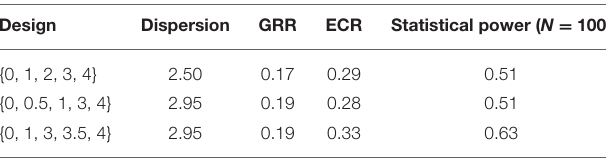
TABLE 2 | Measures of study design quality for different distributions of five measurement occasions over 4 years.